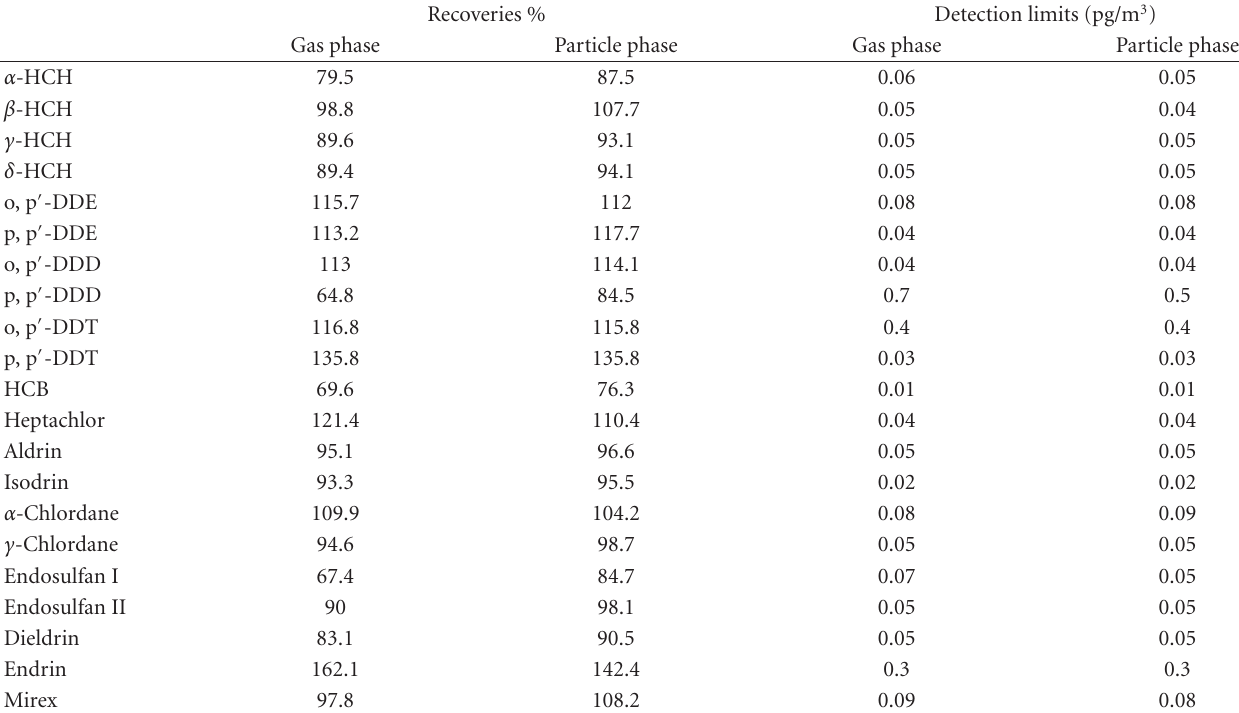
Table 1: Recoveries and detection